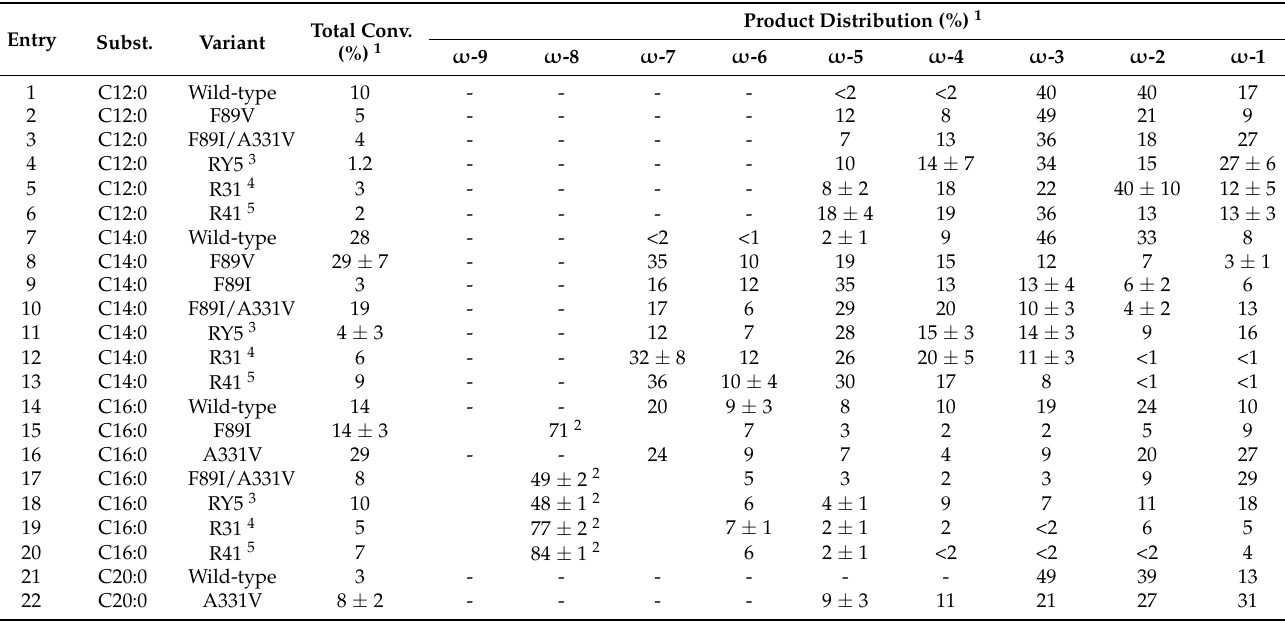
Table 1. Total conversion levels and product distribution of BAMF2522 mutants that exhibit highly preferred selectivity for in-chain